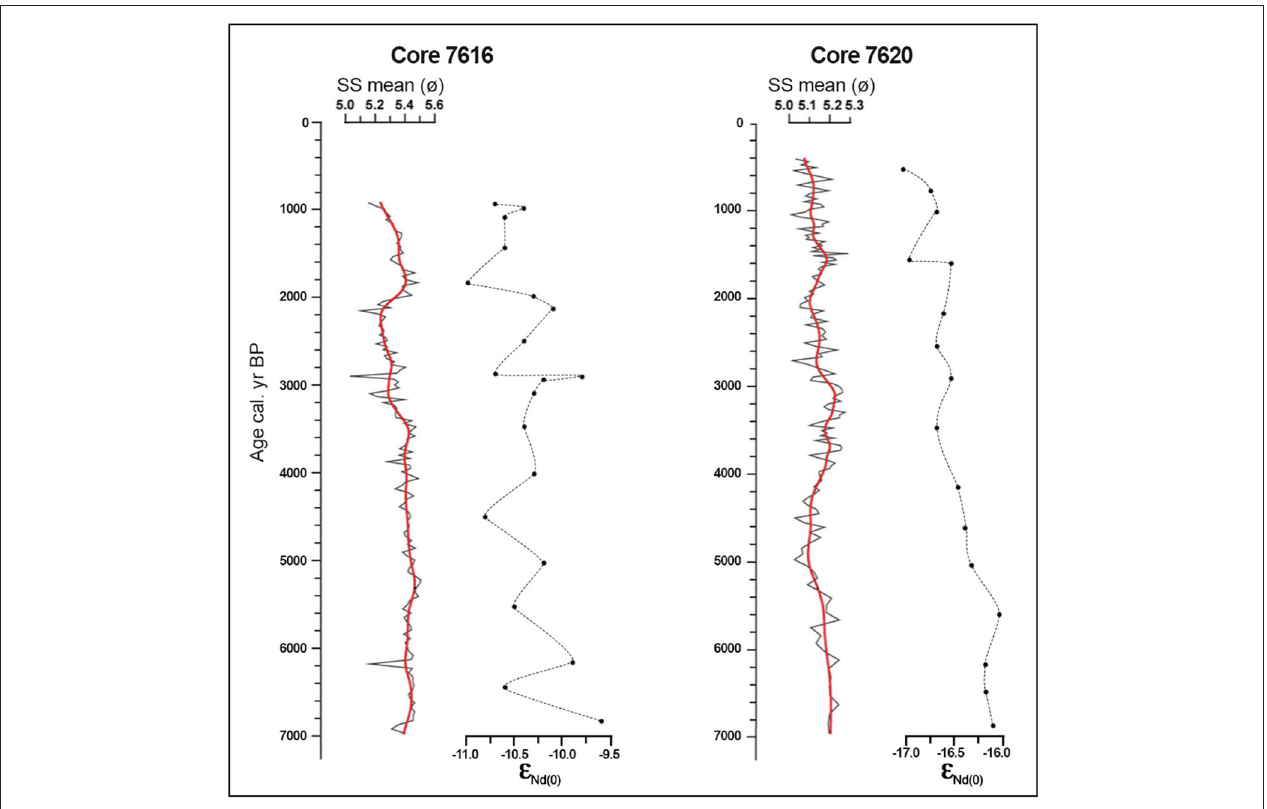
FIGURE 8 | Comparison between the sortable silt (SS) mean reported by Gyllencreutz et al. (2010) and the ε Nd(0) data from the present work for the cores 7616 and 7620. The red line represents the smoothed curve; the black dots are the variation of ε Nd(0) data from the present